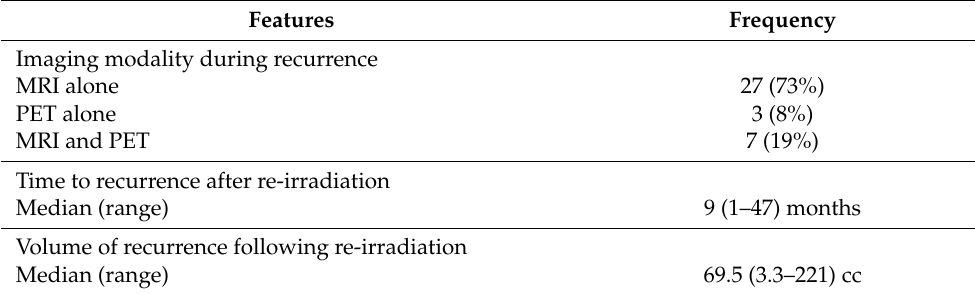
Figure 5. Two patients with central recurrence, each in the upper and lower panel. ( a ) (37-year male with IDH-mutant astrocytoma) shows target volumes (GTV: red, CTV: blue; PTV: magenta) on T2-FLAIR MRI. The CTV was drawn to include all areas of T2w hyperintensity. ( b , c ) is T2-FLAIR and T1w contrast images showing recurrent disease (arrow) and its relation with the 95% isodose line (orange line). ( d ) (56-year male with recurrent glioblastoma) shows the target volumes for another patient volumes (GTV: red, CTV: blue; PTV: magenta) on T1w contrast MRI. The GTV was the enhancing disease, with CTV drawn as an expansion of 10 mm around the enhancing disease. ( e , f ) show the recurrence volumes with respect to target volumes and the 95% isodose line (orange), respectively. The major portion of recurrent disease can be seen lying within the 95% isodose line. Table 3. Features during recurrence following